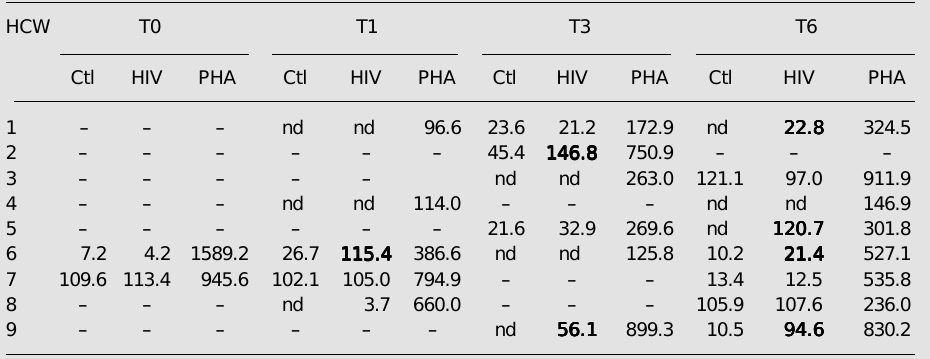
Table 1. Detection of IL-10 in supernatants of PBMC from health care workers (HCW) exposed to an HIV- positive source patient at the time of exposure and during follow-up. HCW T0 T1